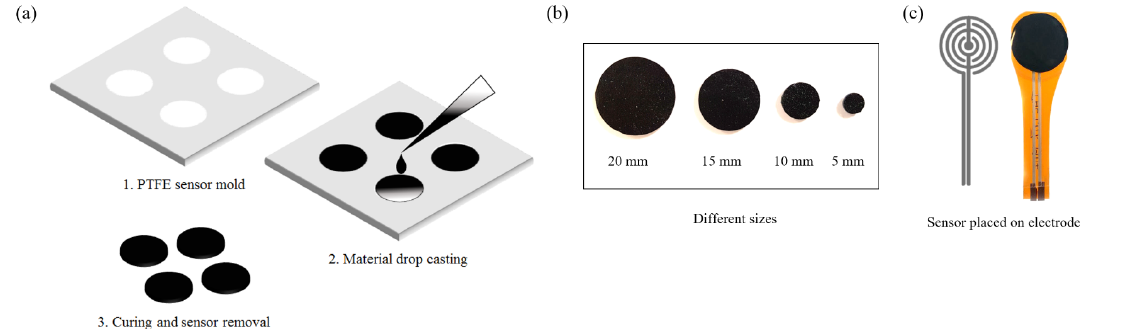
Figure 2. (a) Illustration of the sensor mold-cast process steps; (b) different shapes of the diced sensor; (c) circular interdigital electrodes, screen printed with silver ink for electrical contact with sensor; and sensor placed on the electrode